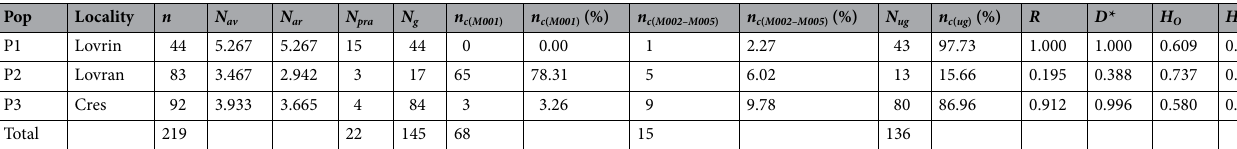
Table 2. Parameters of allelic and clonal diversity of the three sampled populations: P1—Lovrin; P2—Lovran; P3—Cres. n total sample size, N av average number of alleles per locus, N ar allelic richness, N pra number of private alleles, N g number of distinct genotypes, n c(M001) clonal size of the clone M001, n c(M001) (%) % of the samples belonging to the M001, n c(M002–M005) clonal size of the clones M002–M005, n c(M002–M005) (%) % of the samples belonging to the M002–M005, N ug number of unique genotypes, n c(ug) (%) % of the samples belonging to unique genotypes, R genotypic richness, D* Simpson’s complement index, H O observed heterozygosity, H E expected